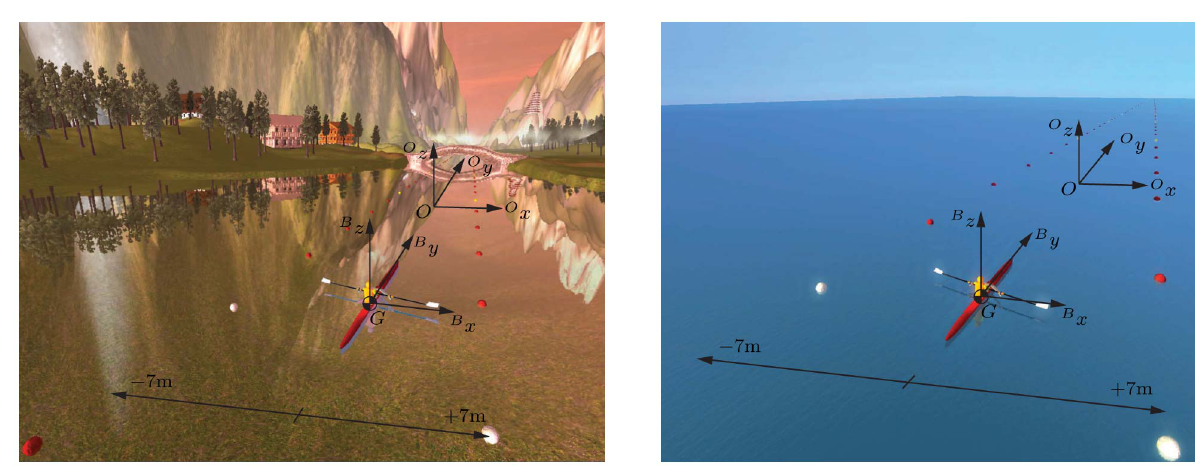
Figure 5. The ocean scenario was used in all participants during the baseline and retention tests. This scenario was designed to prevent the participants from distractions and to focus on their rowing technique. For rendering, a global coordinate system ( K O ) and boat coordinate system ( K B ) where defined. Two lines of buoys limited the rower’s workspace within the scenario. In this way the rower was in a setting comparable to a rowing race and at the same time, the rower could not leave the virtual